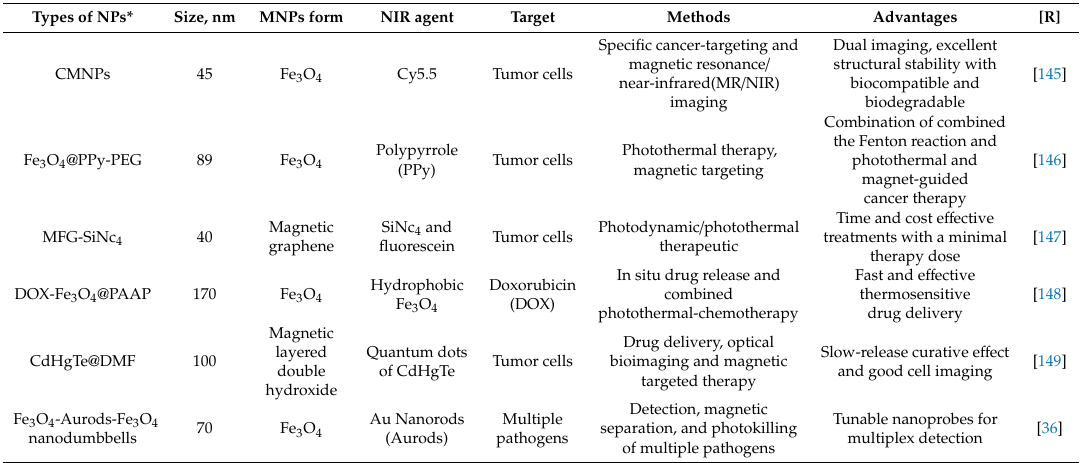
Table 4. Some applications of near-infrared spectroscopy (NIRS) sensors based on